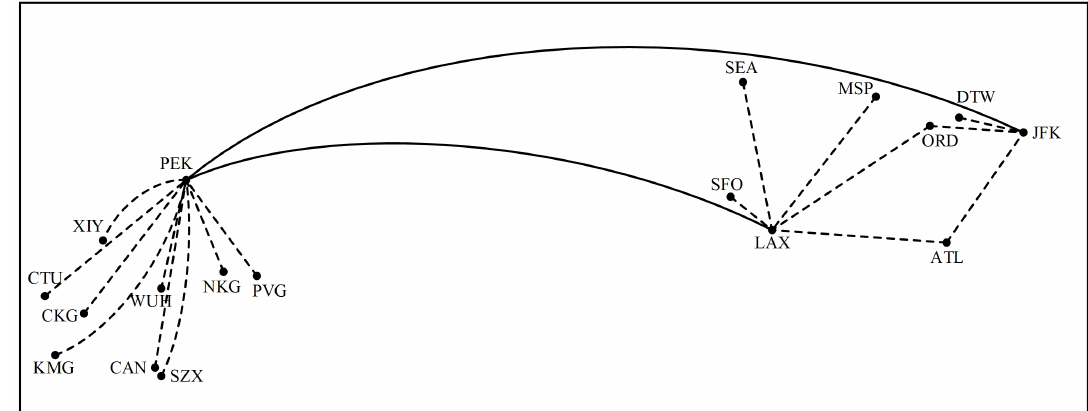
Figure 3. Alliance route network optimization design.